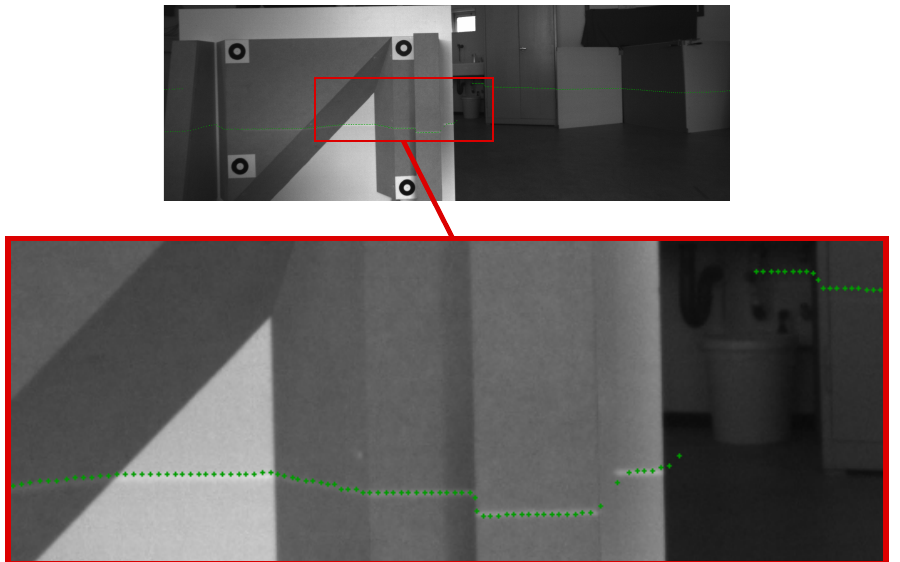
Figure 11. Laser projection into a camera of the Multi-Sensor Pedestrian Navigation System (MSPNS) that detects the laser